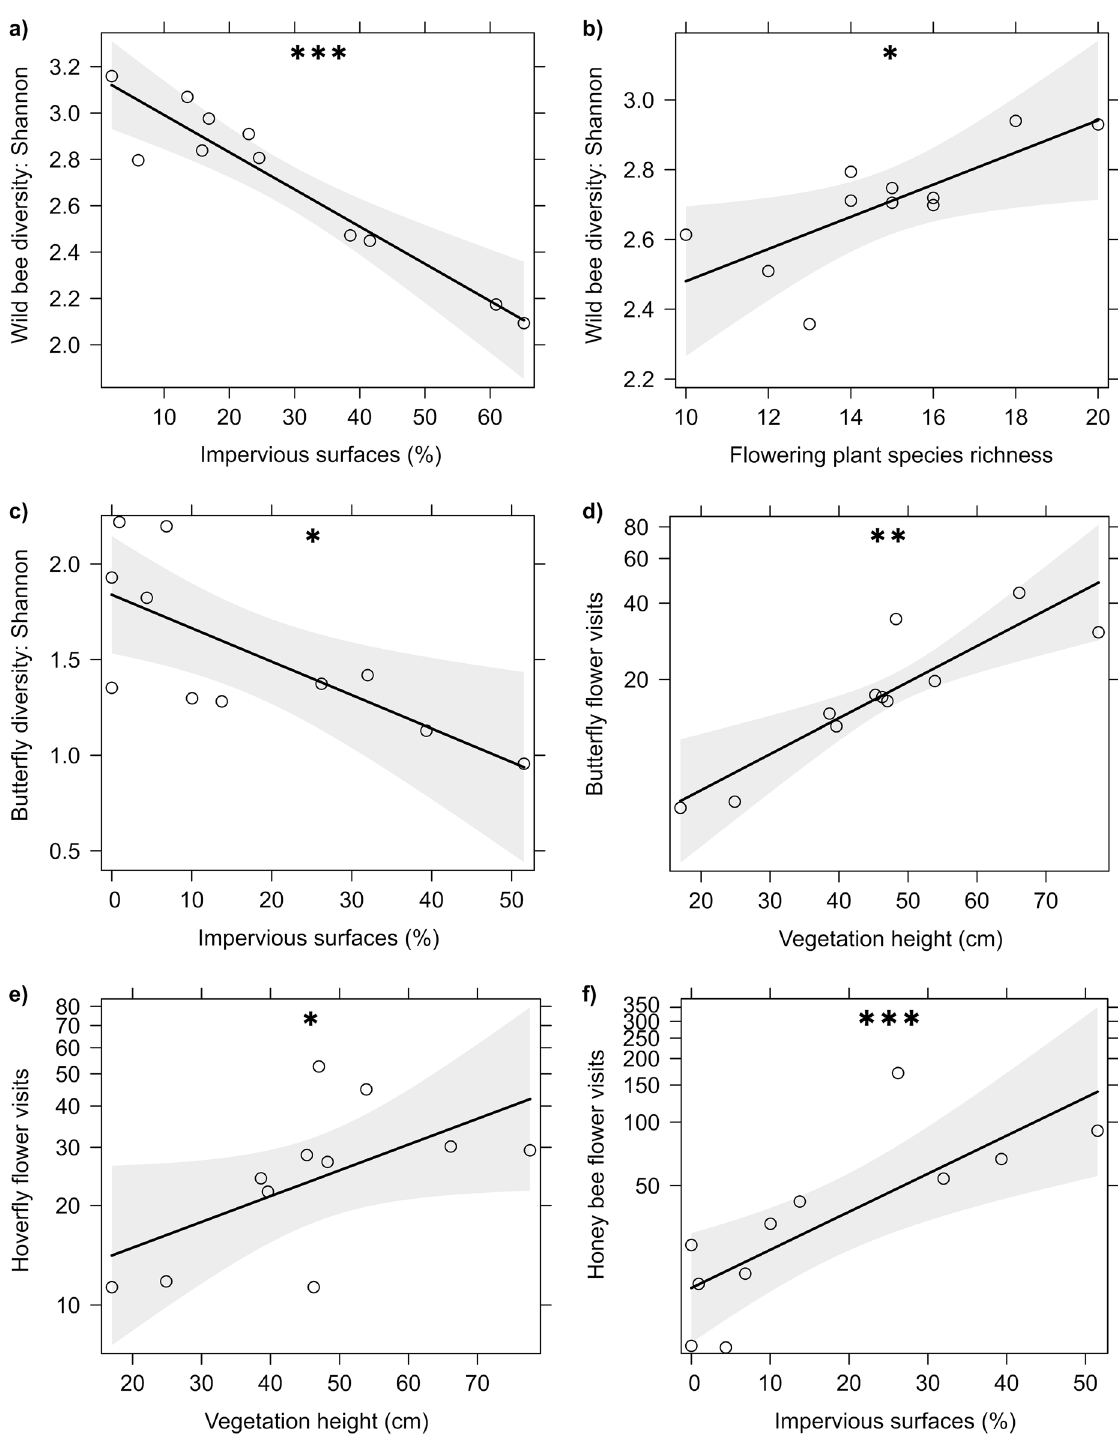
Figure 1. Relationships between ( a ) Shannon diversity of wild bees and impervious surfaces (1000 m); ( b ) Shannon diversity of wild bees and flowering plant richness; ( c ) Shannon diversity of butterflies and impervious surfaces (100 m); ( d ) butterfly flower visits and vegetation height; ( e ) hoverfly flower visits and vegetation height; ( f ) honey bee flower visits and impervious surfaces (100 m). Plotted lines show the predicted relationship and shaded areas indicate the 95% confidence intervals. *P < 0.05; **P < 0.01; ***P <